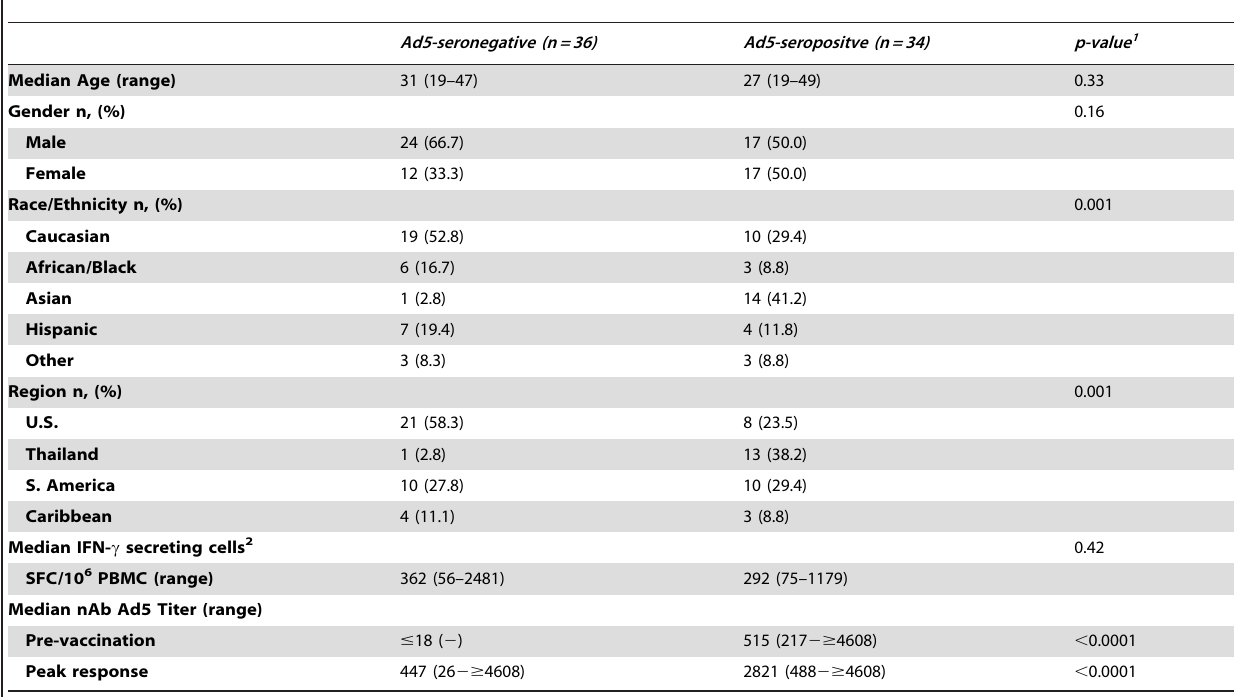
Table 1. Demographic characteristics of study